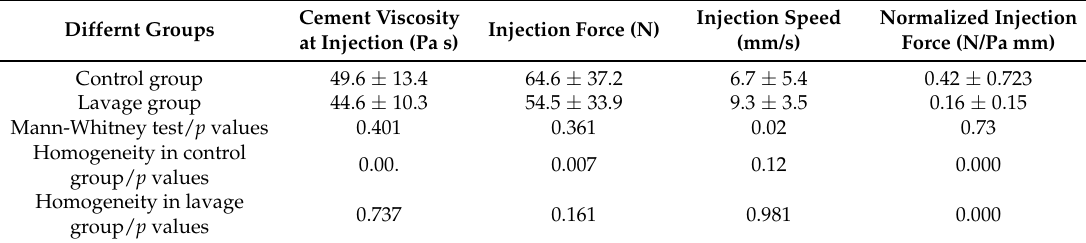
Table 1. Mean ± standard deviations for the measured and calculated parameters: cement viscosity at injection, injection forces, injection speed, and normalized injection force. Adapted from [7], with permission from © 2009